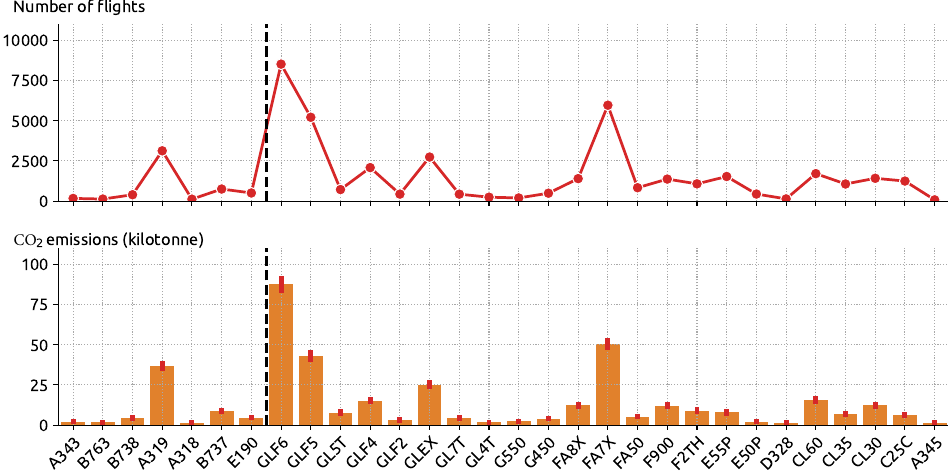
Figure 5. Absolute number of flights and CO 2 emissions by privately owned aircraft. The dashed line separates the common airliner types from the light jets. Sample of 250 privately owned jets and their flights between 2019 and